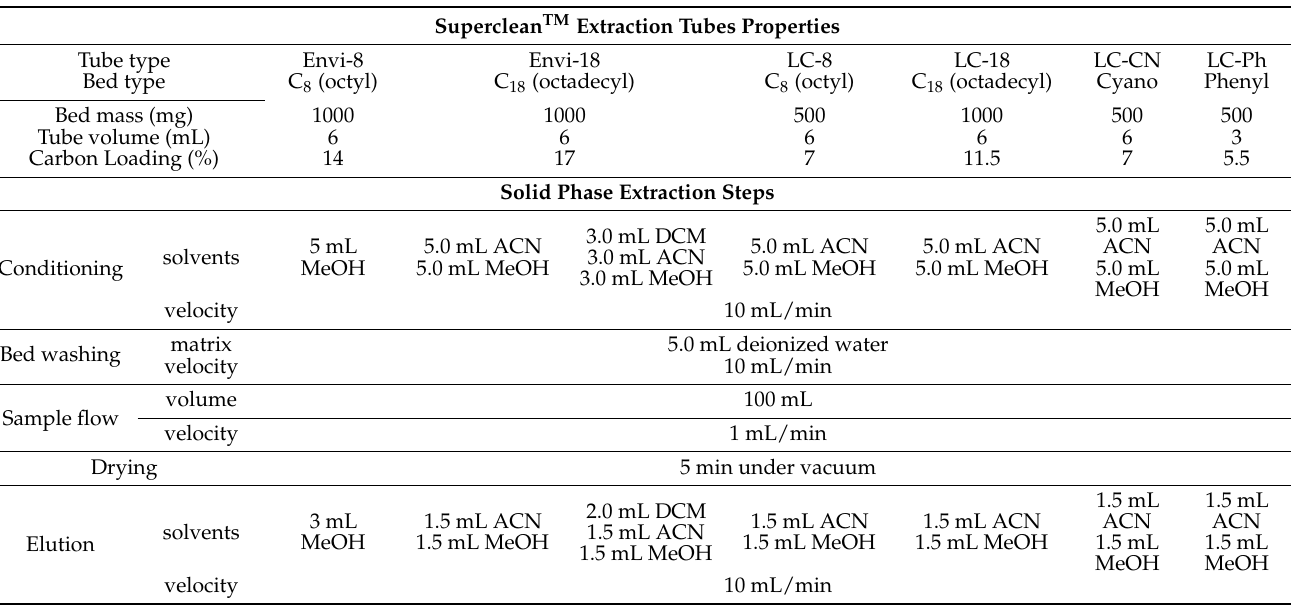
Table 2. Detailed parameters of the extraction processes.